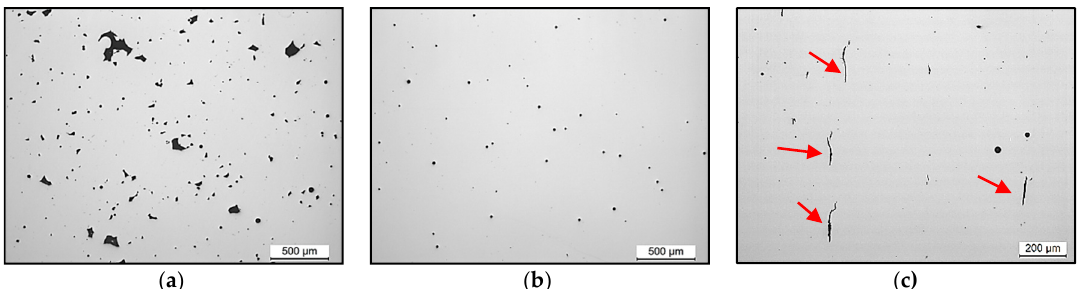
Figure 3. IN738LC samples showing different type of defects: ( a ) lack of fusion, ( b ) pores and ( c ) cracks (indicated by an arrow) and pores.